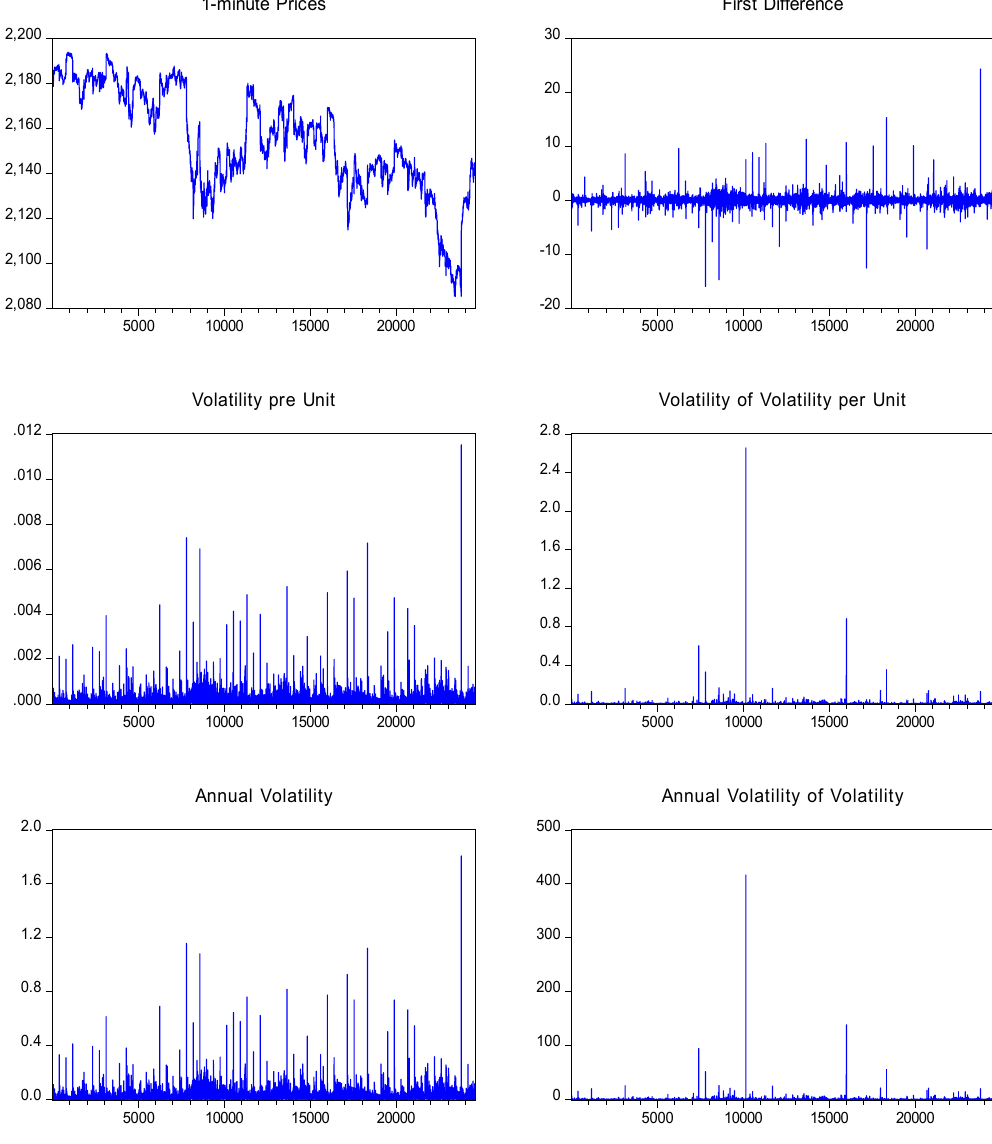
Figure 1. Plot of the S&P 500 1-min sample.